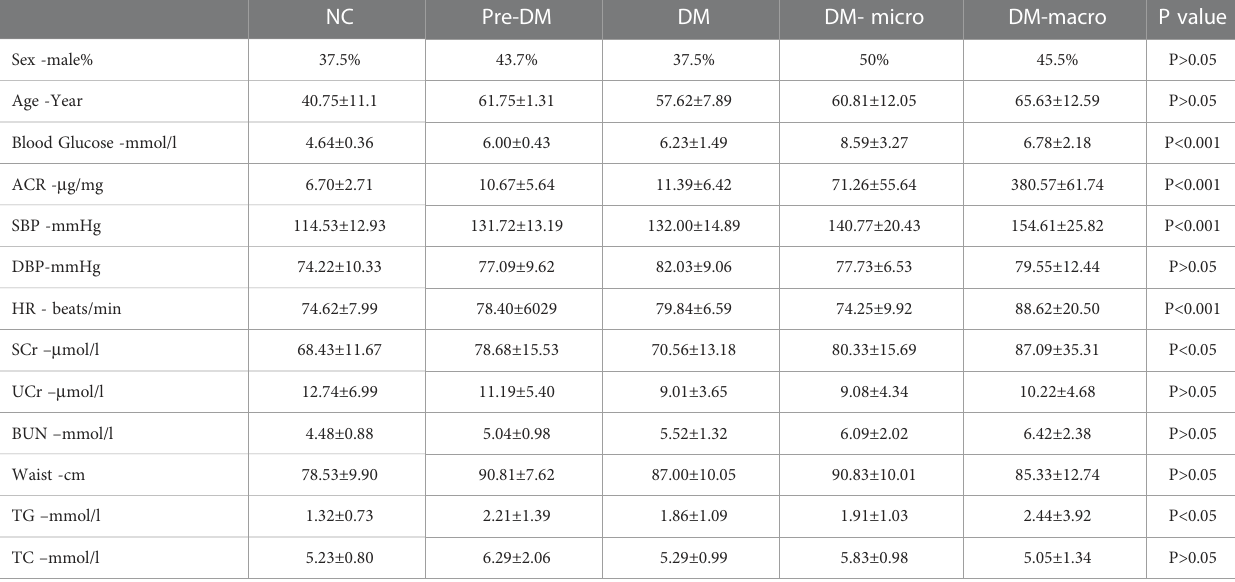
TABLE 1 Characteristics of participants in different